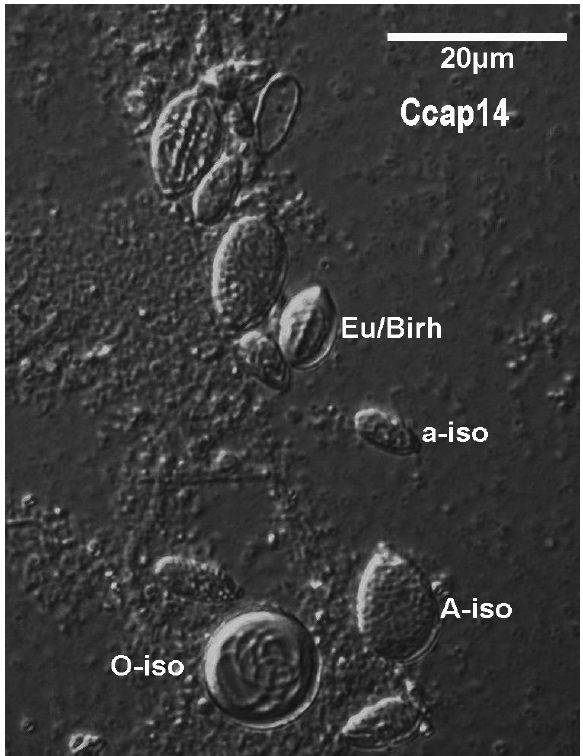
Fig . 1. – Micrograph of A-, a-, O-isorhizas and euryteles/birhopal- oids in a suspension of nematocysts of Cyanea capillata medusae (Ccap14, 9 medusae; average umbrella diameter 14.2 cm) obtained from oral arm tissue.